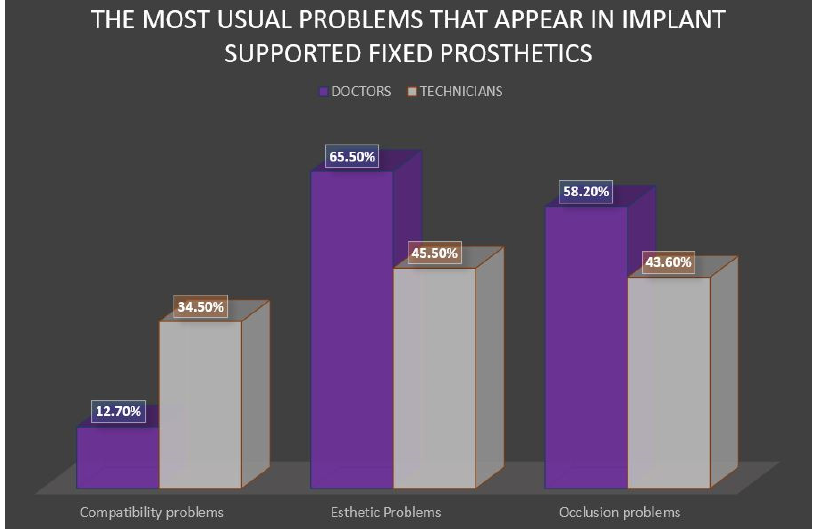
Figure 5. The most usual problems that appear in implant supported fixed prosthetics: doctors vs. technicians.